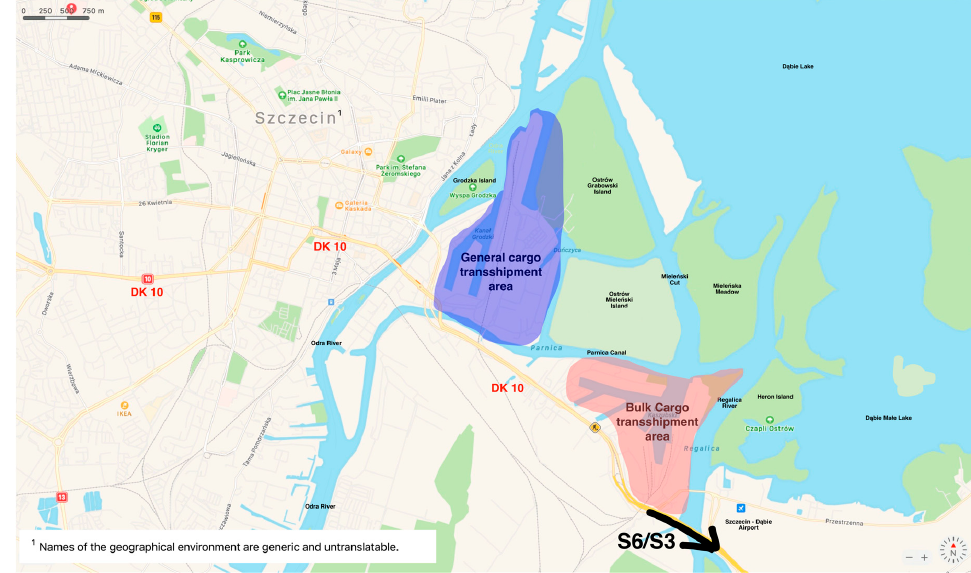
Figure 1. State Road DK10 and port areas in the city of Szczecin. Source: Own study based on www.openstreetmap.org (accessed on 22 June